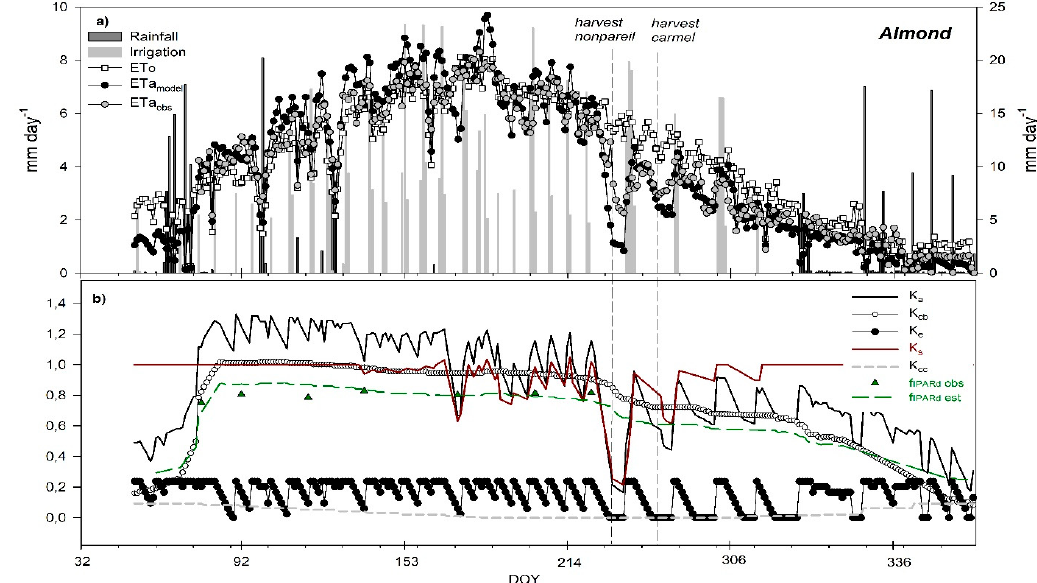
Figure 9. Seasonal trends of the different parameters contributing to evapotranspiration of the almond orchard: ( a ) ETa model and ETa obs (flux tower) throughout the growing season along with ETo, rainfall and irrigation; ( b ) modeled actual crop coefficient (K a ), basal crop coefficient (K cb ), soil water evaporation coefficient (K e ), water stress coefficient (K s ), cover crop coefficient (K cc ), and the observed (f IPAR d obs) and estimated (f IPAR d est) daily fraction of intercepted radiation.